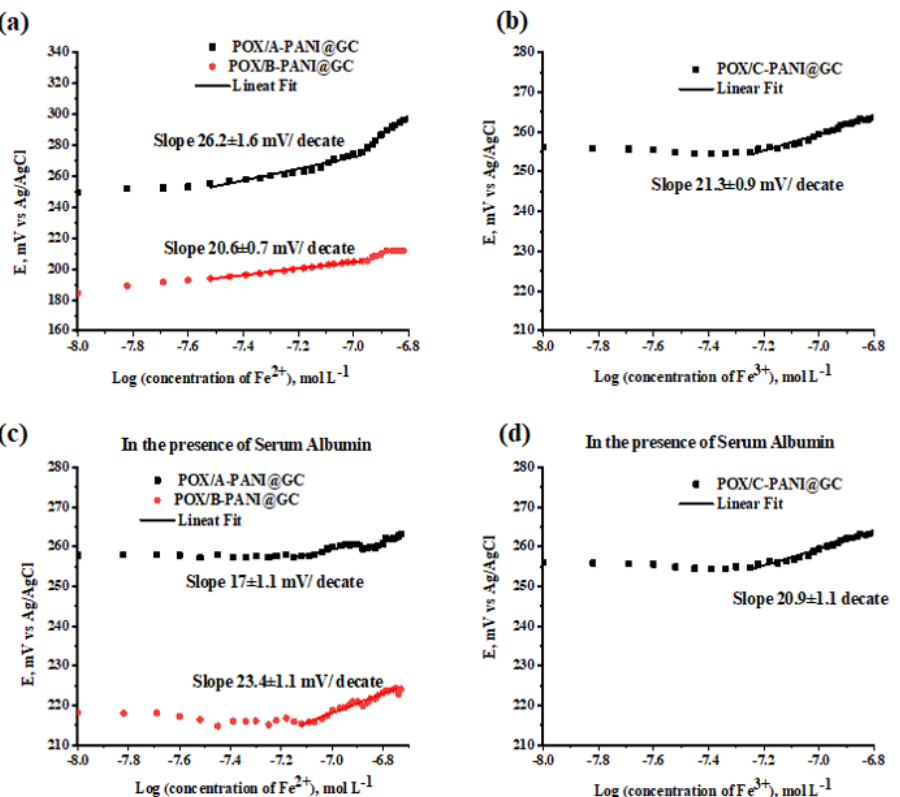
Figure 6. ( a ) Potentiometric detection of Fe 2+ ions by POX/A-PANI@G.C and POX/B-PANI@G.C without BSA; ( b ) potentiometric detection of Fe 3+ ion by POX/C-PANI@G.C without BSA; ( c ) poten- tiometric detection of Fe 2+ ions by POX/A-PANI@G.C and POX/B-PANI@G.C with BSA; and ( d ) potentiometric detection of Fe 3+ ion by POX/C-PANI@G.C with BSA.